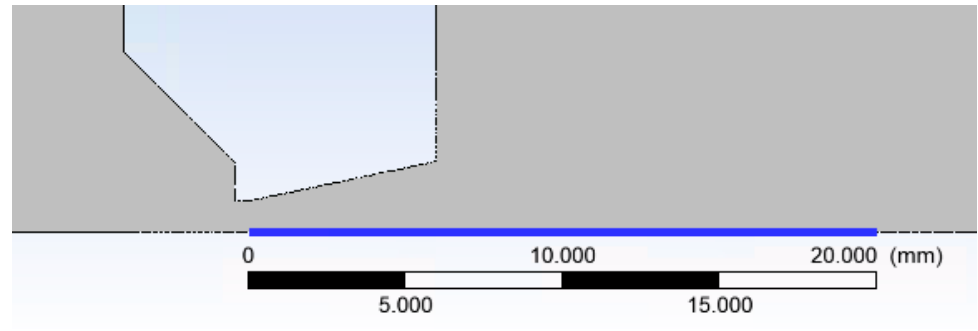
Figure 2. Cross-section through the experimental chamber in the aperture area.